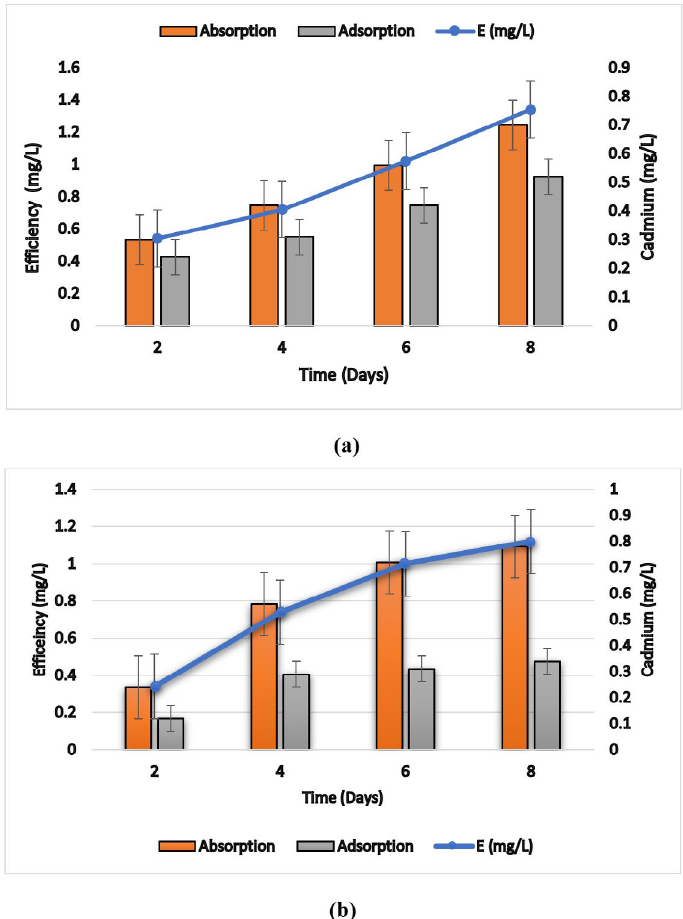
Fig. 4. Biosorption of Cd by using heat inactivated cells of a) Bacillus sp. ECd004 , b) Cuprividus